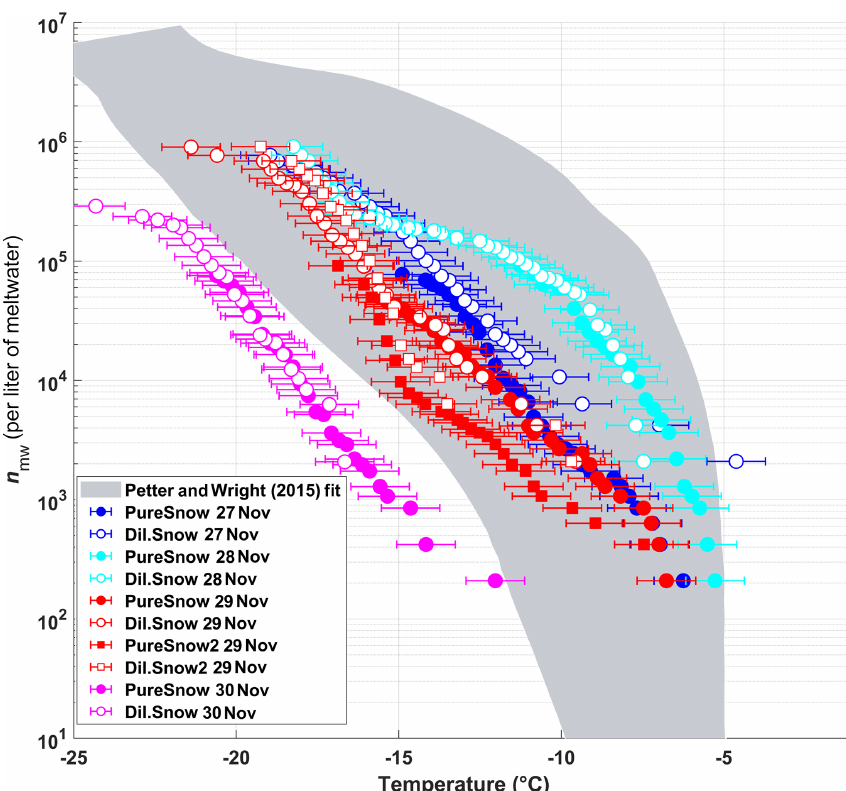
Figure 10. The cumulative number of active sites per liter of meltwater ( n mw ) of snow for undiluted snow (filled) and of snow samples diluted by a factor of 10 (white-filled symbols) as a function of temperature. The colors represent the different sampling days. On 29 November two samples were taken, and the second sample of the day is indicated by square symbols. The shaded area represents the previously reported n mw from precipitation events as described in Petters and Wright (2015). The error bars represent the instrumental temperature uncertainty of ± 0 . 9 ◦